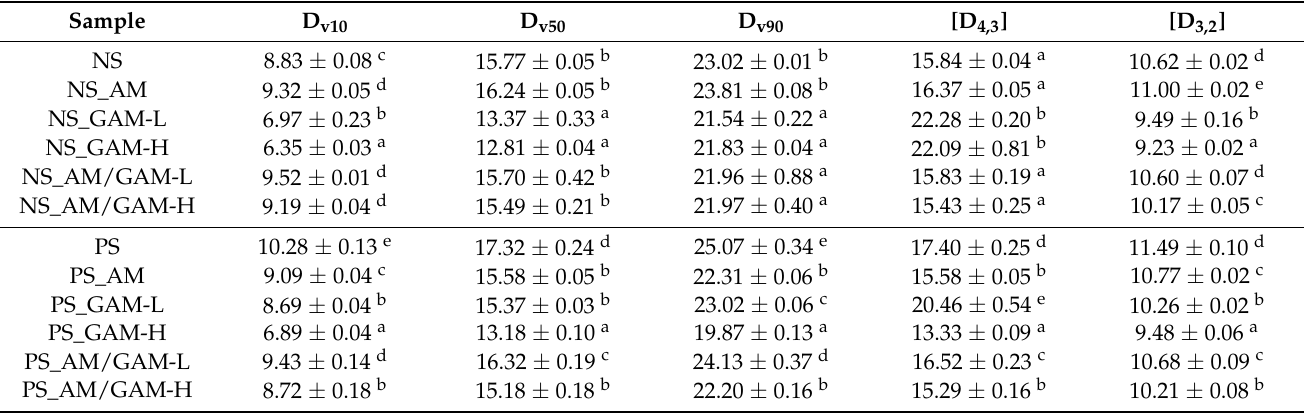
Table 1. Particle size parameters of starch